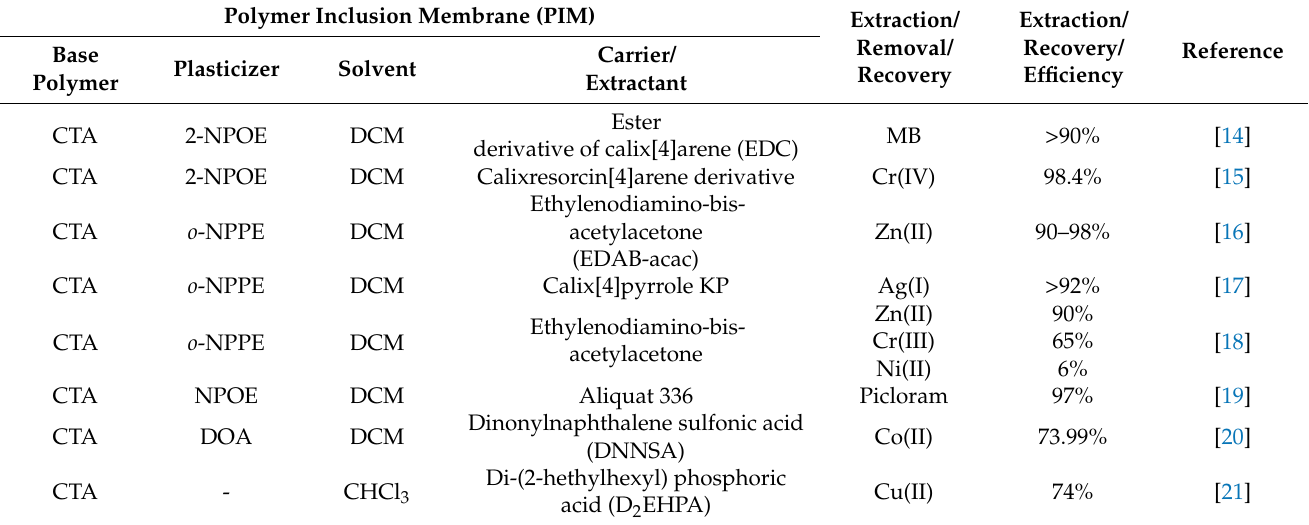
Table 1. Examples of PIMs with different formulations and their applications. Polymer Inclusion Membrane